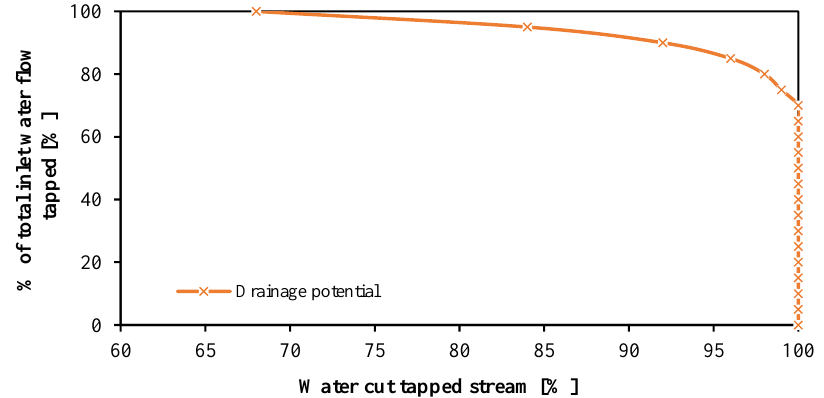
Figure 2. Drainage potential curve. Taken from [5].